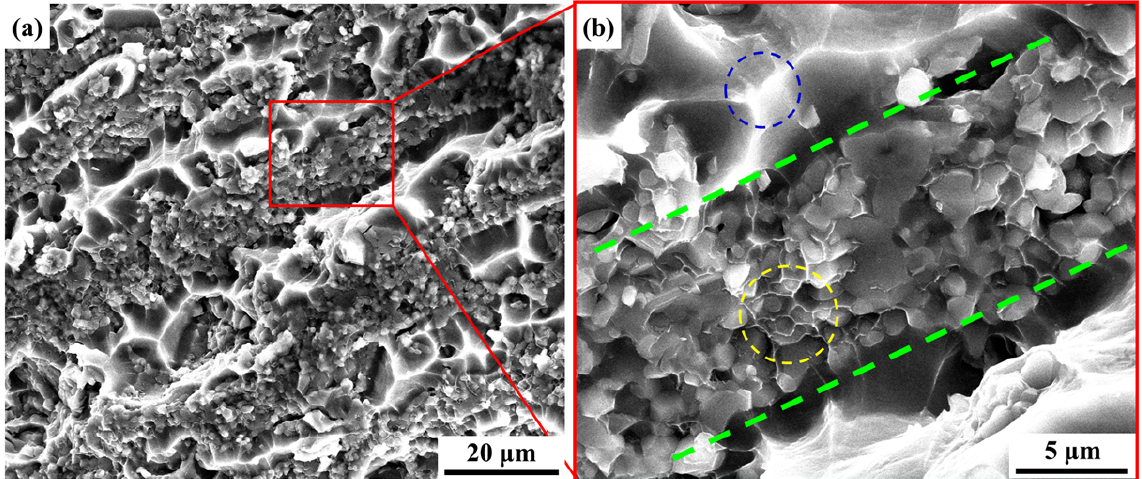
Figure 7: SEM observation of the fracture surface of the lamellar Al 2 O 3 p/Al composite. (a) Low magnification image, (b) High magnification of the selected area in